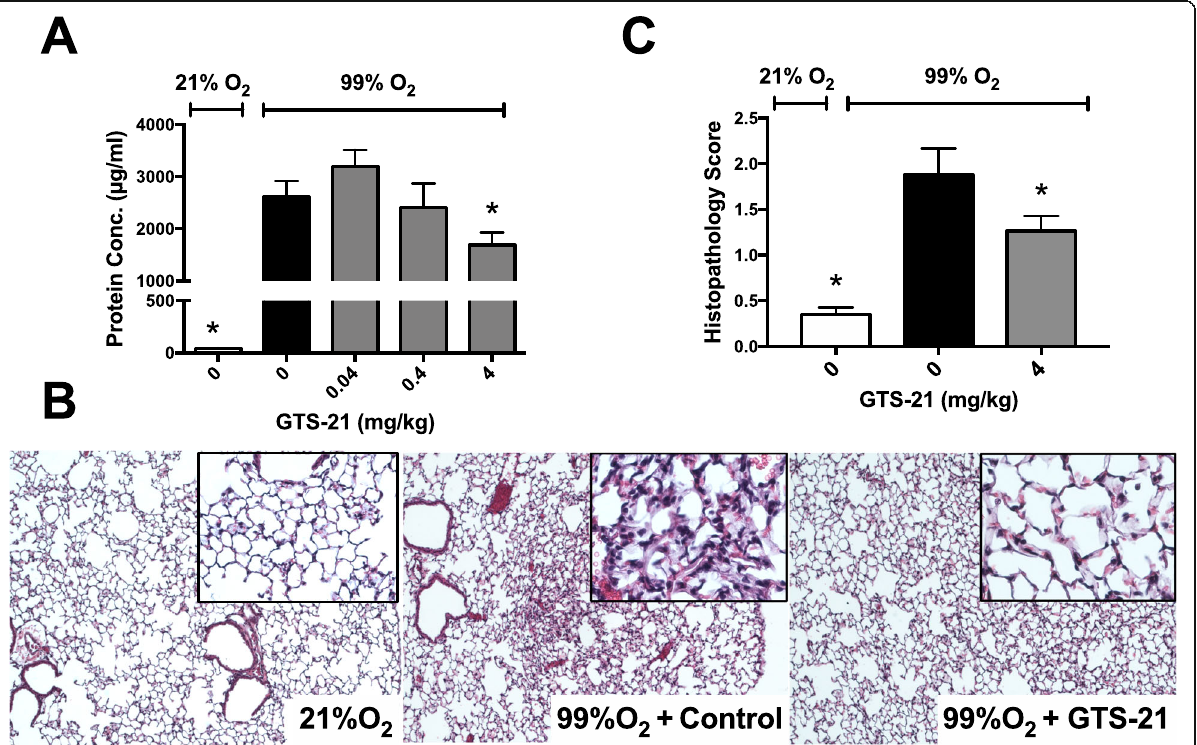
Fig. 1 Systemic administration of GTS-21 decreases lung injury in mice exposed to prolonged hyperoxia. C57BL/6 mice were exposed to either ≥ 99% O 2 for 3 days or 21% O 2 (room air). Mice were randomized to receive either GTS-21 (0.04, 0.4 and 4mg/kg) or saline, administrated by intraperitoneal injection every 8h starting at 32h following the onset of hyperoxic exposure. Lungs and BAL were harvested at the end of hyperoxia treatment. a The total protein content in the BAL was measured as a marker of lung injury. b-c Lungs, harvested at the end of hyperoxic exposure, were fixed, embedded and sectioned. Images of the Hematoxylin-eosin-stain of the lung sections from room air samples (RA), and hyperoxic samples from mice treated with either vehicle saline control (0m/kg) or GTS-21, (4mg/kg) are shown ( b ) and their lung histopathological scores assessed ( c ). Data represent the mean±SEM from three independent experiments ( n =6 – 10 mice/group). * p <0.05, compared with mice receiving normal